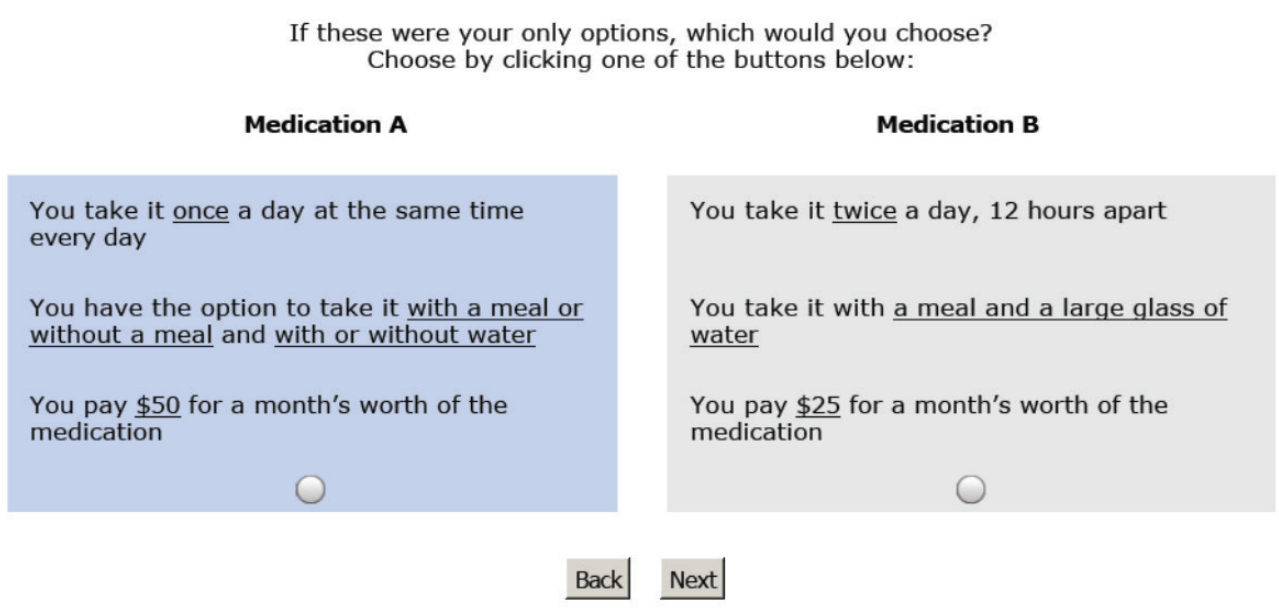
Figure 1. Screen Shot of Sample Conjoint Choice